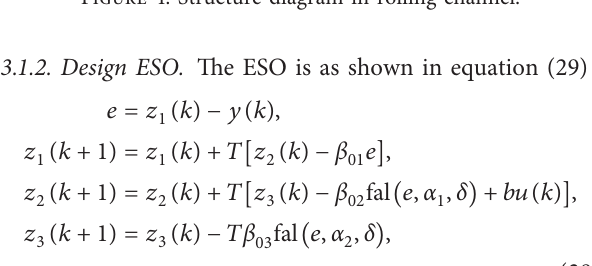
Figure 4: Structure diagram in rolling